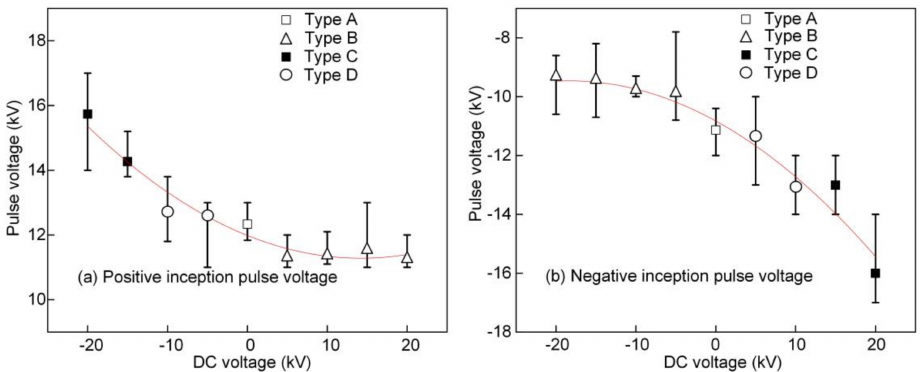
Figure 3. Tree inception pulse voltage with different DC: ( a ) positive inception pulse voltage; ( b ) negative inception pulse voltage.